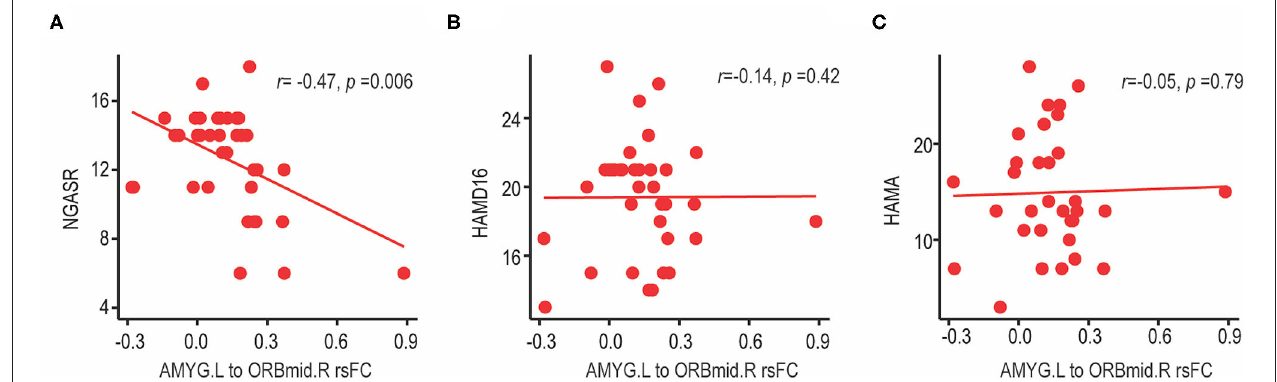
FIGURE 2 | Correlation between left amygdala-right middle frontal gyrus (orbital part) rsFC and clinical characteristics in BD-II depression patients with suicide attempts. (A) The left amygdala-right middle frontal gyrus (orbital part) rsFC showed a significant negative correlation with suicide risk (measured by NGASR score). FCs were Fisher z-transformed and relationship was analyzed using partial correlation controlling for age, education, mean FD factors and HAMD-16 score (without three-item, suicide). (B) There was no association between the left amygdala-right middle frontal gyrus (orbital part) rsFC and the severity of depressive symptoms (measured by HAMD-16 scores, without suicide-item), or (C) severity of anxiety symptoms (measured by HAMA score). NGASR, Nurses’ Global Assessment of Suicide Risk; HAMD, Hamilton Depression Rating Scale; HAMA, Hamilton Anxiety Rating Scale; AMY.L, left amygdala; ORBmid.R, right middle frontal gyrus (orbital part).